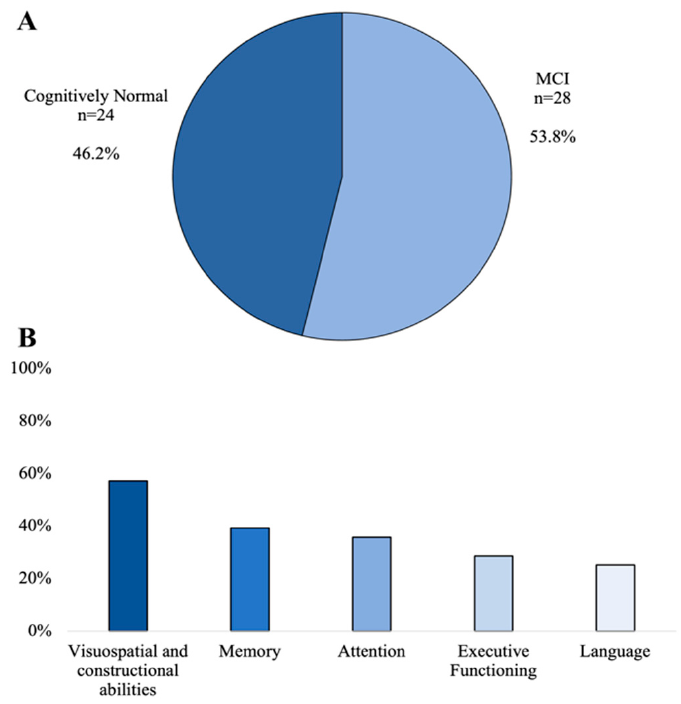
Figure 1. Frequency of MCI ( A ) and impaired cognitive domains ( B ) in our sample. Table 1. Demographic, clinical, immunological, and cognitive/behavioral differences between CN and MCI patients.